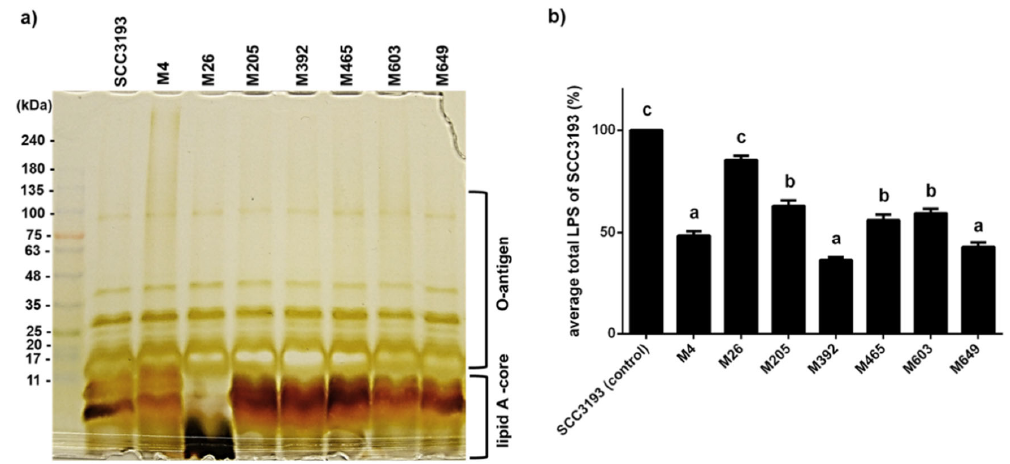
Figure 3. Characterization of lipopolysaccharide (LPS) from wild ‐ type P. parmentieri strain SCC 3193 and seven phage ‐ resistant mutants. ( a ) SDS ‐ PAGE was performed using a gradient (4–20%) polyacrylamide gel, and the LPS components were visualized by silver staining [37]. The size marker (11–245 kDa, Perfect Tricolor Protein Ladder, EURx, Poland) is shown in the first lane. ( b ) Quantification of the total LPS produced by wild ‐ type SCC 3193 strain and seven phage ‐ resistant bacterial mutants was done using Pierce™ LAL Chromogenic Endotoxin Quantitation Kit (ThermoFisher Scientific, Warsaw, Poland) according to a protocol provided by the manufacturer. The concentration of LPS of the Tn5 mutants is expressed as % of the LPS amount produced by the wild ‐ type SCC 3193 strain. The means that do not share the same letters above each bar differ ( p = 0.05). The experiment was repeated three times (each biological replicate contained two technical replicates), and the results were averaged for analysis. Vertical lines represent standard deviation (SD). 2.5. Mass Spectrometry Analysis of the P. parmentieri SCC 3193 and Tn5 Mutants’ Surface Proteins Whole ‐ cell MALDI ‐ TOF fingerprinting technique was used to compare the bacterial surface proteins of the WT strain with these of the phage ‐ resistant mutants. The initial